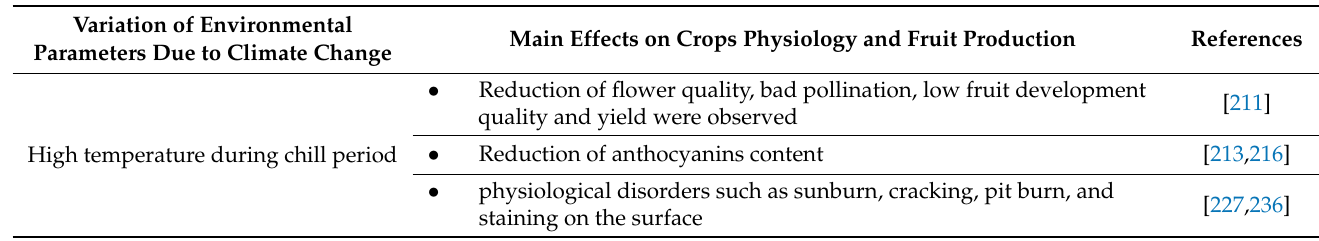
Table 11. Summary of principal effects of environmental conditions variation on peach